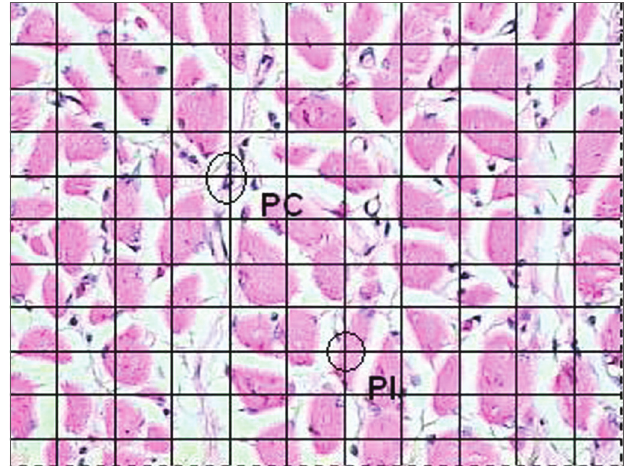
Figura 2. Corte histológico coronal da prega vocal canina direita com sacrifício após 90 dias. Coloração hematoxilina-eosina. Análise quantitativa do processo inflamatório. Grade quadriculada contendo 10 linhas verticais e 10 linhas horizontais, contabilizando 100 pontos de intersecção. Os pontos foram contados em 2 grupos: pontos de coincidência (PC) que continham células inflamatórias e pontos de inclusão (PI) correspondendo ao restante dos pontos. O processo inflamatório de cada região foi medido através de uma média dos pontos de coincidência dos 10 campos analisados (400x).